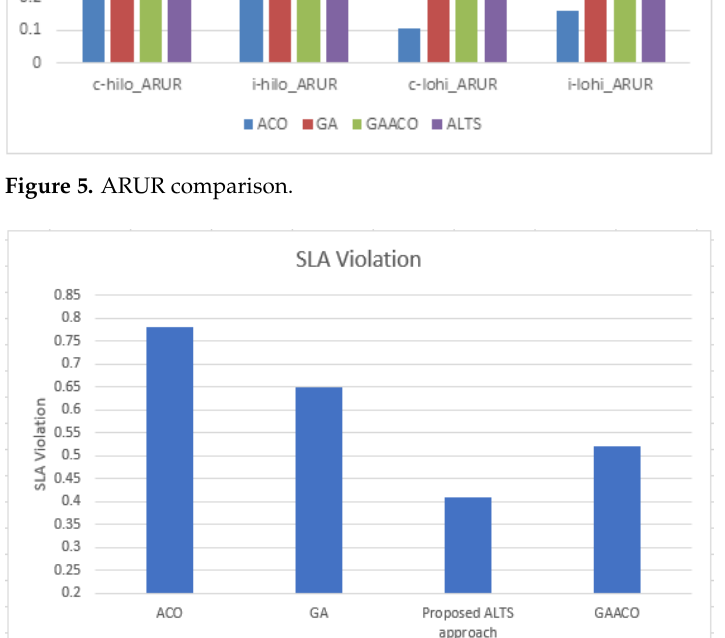
Figure 6. Average SLA violation